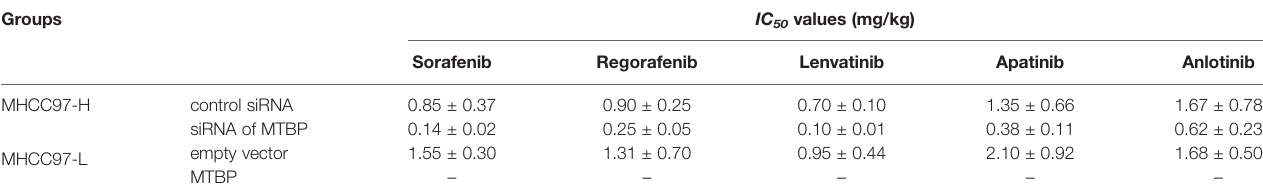
TABLE 3 | MTBP decreased the in vivo antitumor effect of molecular targeting agents. Groups IC 50 values (mg/kg)